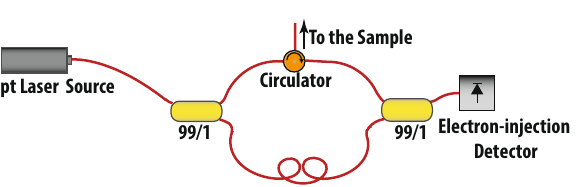
Figure 5. Schematic of a compact OCT system utilizing the electron-injection